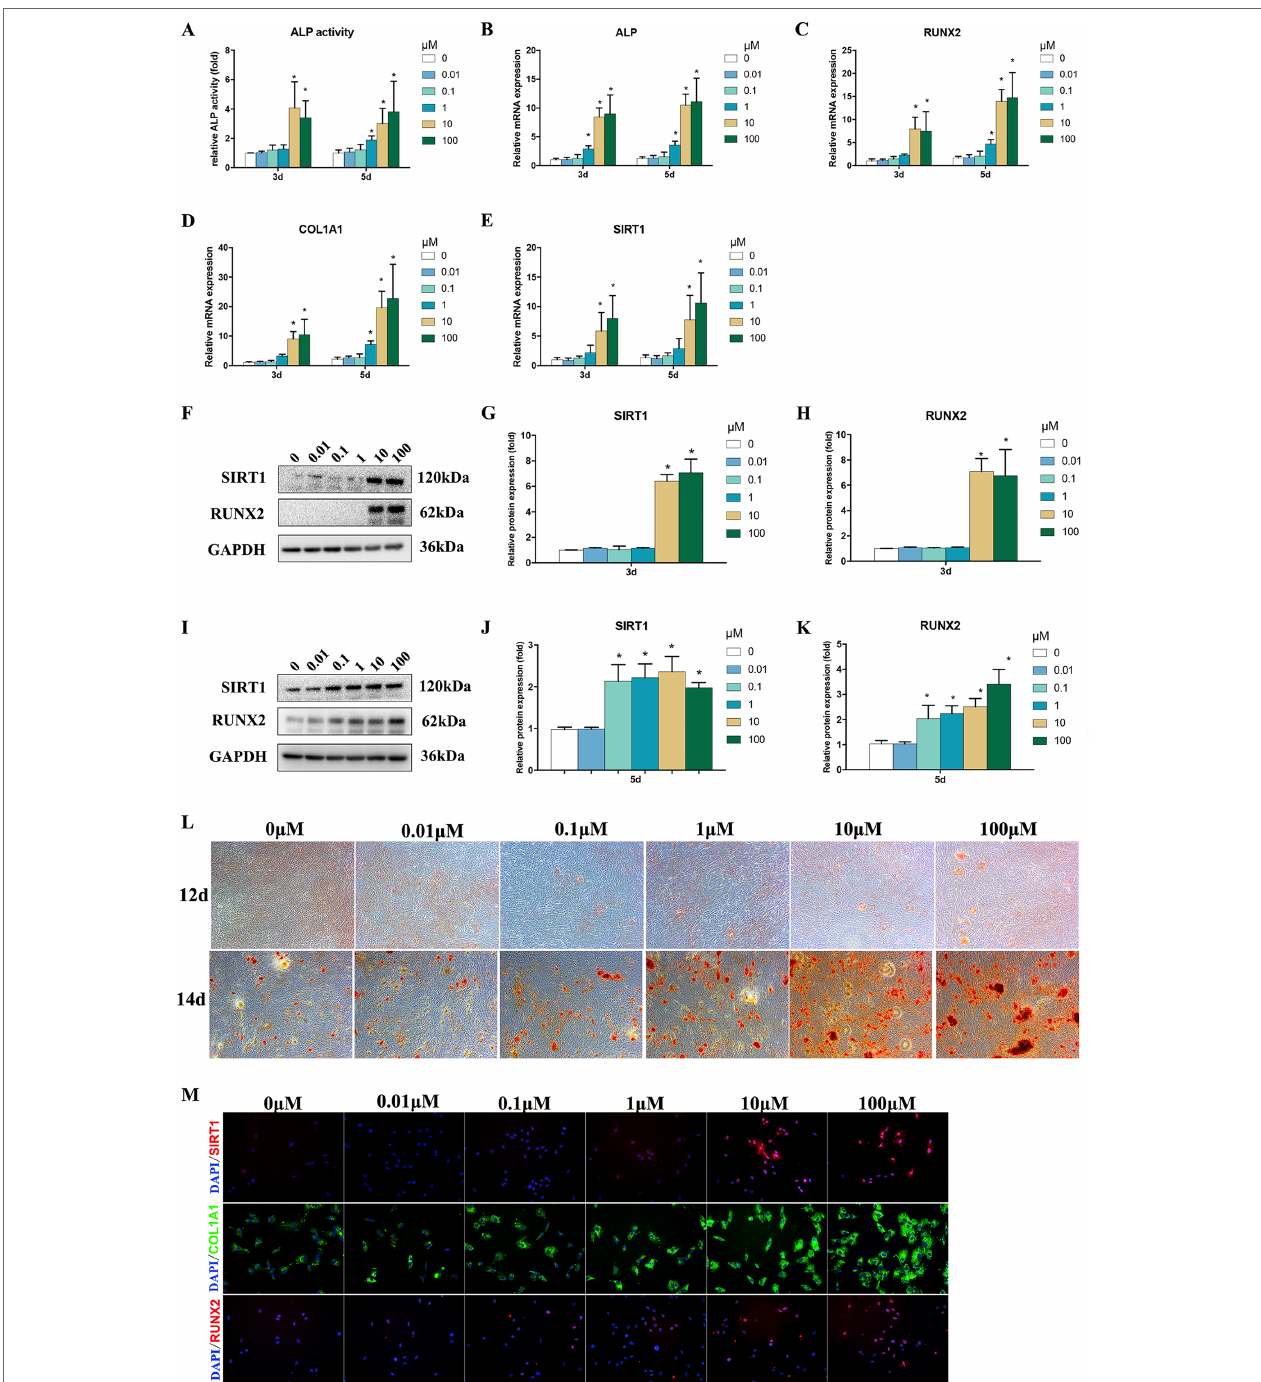
FIGURE 2 | Effects of Bergenin on osteogenesis of bone marrow mesenchymal stem cells (BMSCs). (A) The effects of Bergenin on alkaline phosphatase activity at days 3 and 5 during the osteogenic differentiation of BMSCs. (B – E) mRNA expression of RUNX2, ALP, and COL1A1 was determined by quantitative reverse transcription polymerase chain reaction at day 3 and day 5 during osteogenic differentiation. mRNA expression levels were normalized to GAPDH. (F – K) The expression of RUNX2 and SIRT1 protein was determined by Western blot analysis after osteogenic differentiation at days 3 and 5. Protein expression levels were normalized to glyceraldehyde-3-phosphate dehydrogenase. Data are expressed as the mean ± standard deviation (SD) of three independent experiments, and one of three independent experiments is shown. Data are expressed as the mean ± SD, n = 3. * P < 0.05 vs. BMSCs treated with osteogenic induction medium alone. (L) Alizarin red staining at days 12 and 14 of osteogenic differentiation. Magnification ×40. (M) Immunofluorescence staining showing that the protein levels of RUNX2, COL1A1, and SIRT1 are upregulated by the addition of Bergenin (10 or 100 μM) at day 3 of osteogenic differentiation. COL1A1 is stained green. RUNX2 and SIRT1 are stained red. Nuclei are stained with 4 ′ ,6-diamidino-2-phenylindole (blue). Magnification